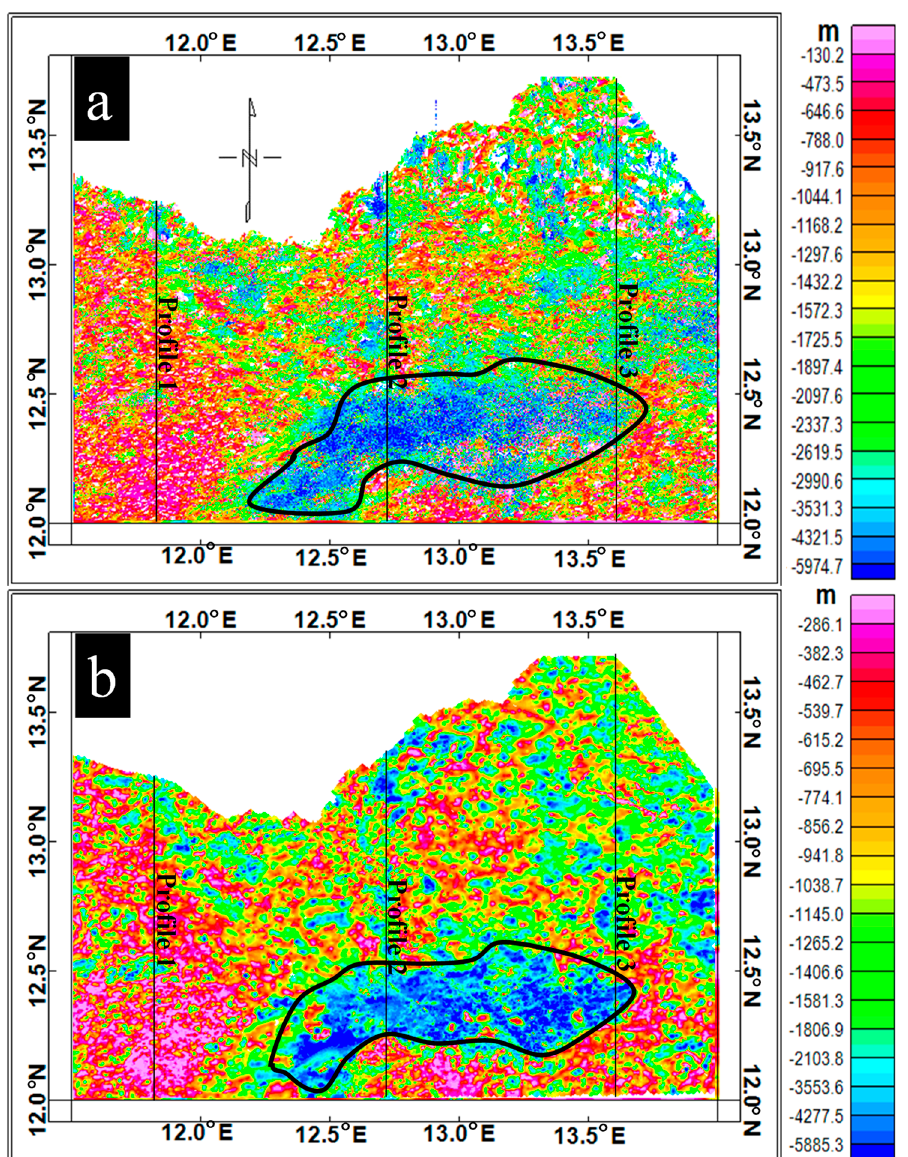
Figure 4. ( a ) Standard Euler deconvolution (structural index = 1.0; max. % depth tolerance = 15.0, window size = 10) and ( b ) source parameter imaging maps.